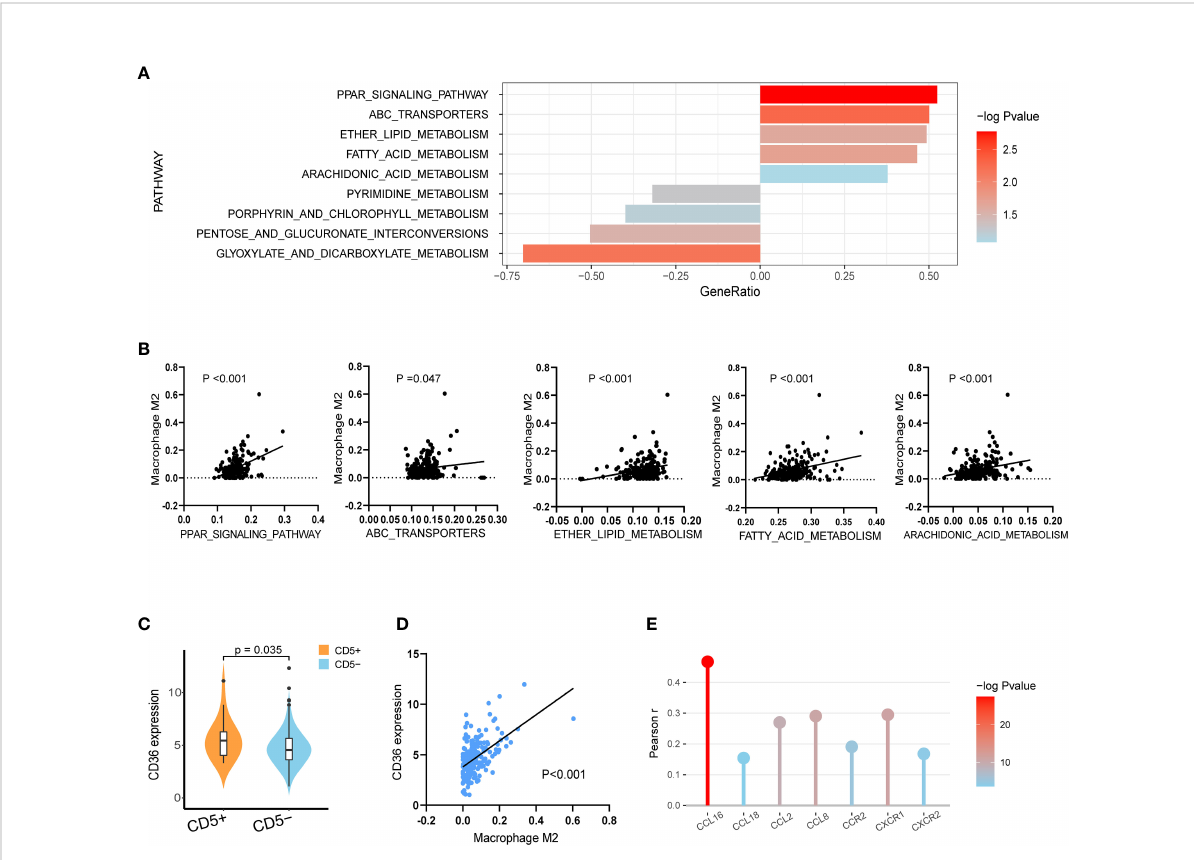
FIGURE 4 Transcriptional analysis of lipid metabolism alterations in CD5+ non-DE patients. (A) The most variable metabolic process upregulated in CD5+ non-DE (n = 20) patients (gene ratio above 0.00) or CD5 − non-DE (n = 188) patients (gene ratio below 0.00) based on Kyoto Encyclopedia of Genes and Genomes (KEGG) pathways. (B) Correlation between M2 proportions and signature scores of PPAR signaling pathway, ATP-binding cassette transporters pathway, ether lipid metabolism, fatty acid metabolism pathway, and arachidonic acid metabolism pathway in non-DE patients (n = 208). (C) Comparison of normalized CD36 expression between CD5+ non-DE (n = 20) and CD5 − non-DE (n = 188) patients. (D) Correlation between M2 proportion and normalized CD36 expression. P value was labeled in the graph. (E) Correlation between